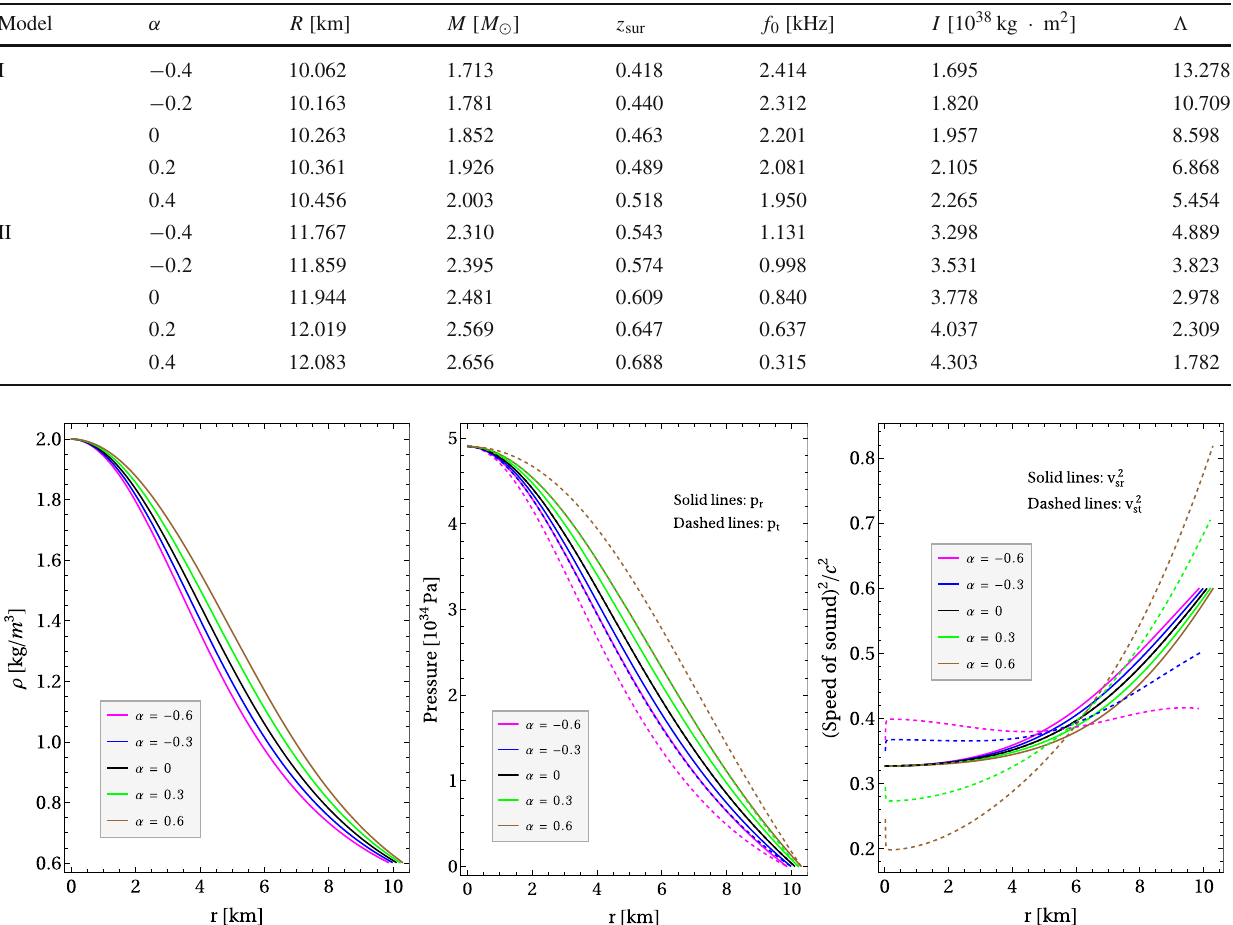
Fig. 2 Radialbehaviorofthemassdensity(leftpanel),pressures(mid- dlepanel)andsquaredspeedofsound(rightpanel)insideananisotropic dark energy star with central density ρ c = 2 . 0 × 10 18 kg/m 3 and several values of the parameter α . All plots correspond to model I and the black